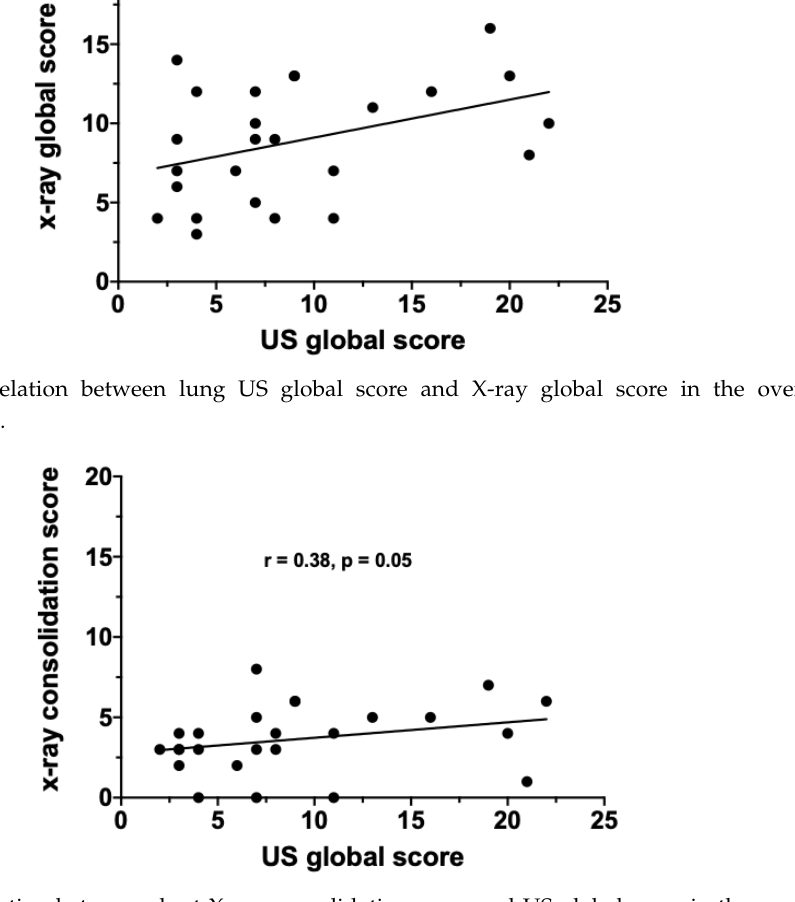
Figure 4. Correlation between chest X-ray consolidation score and US global score in the overall study population.